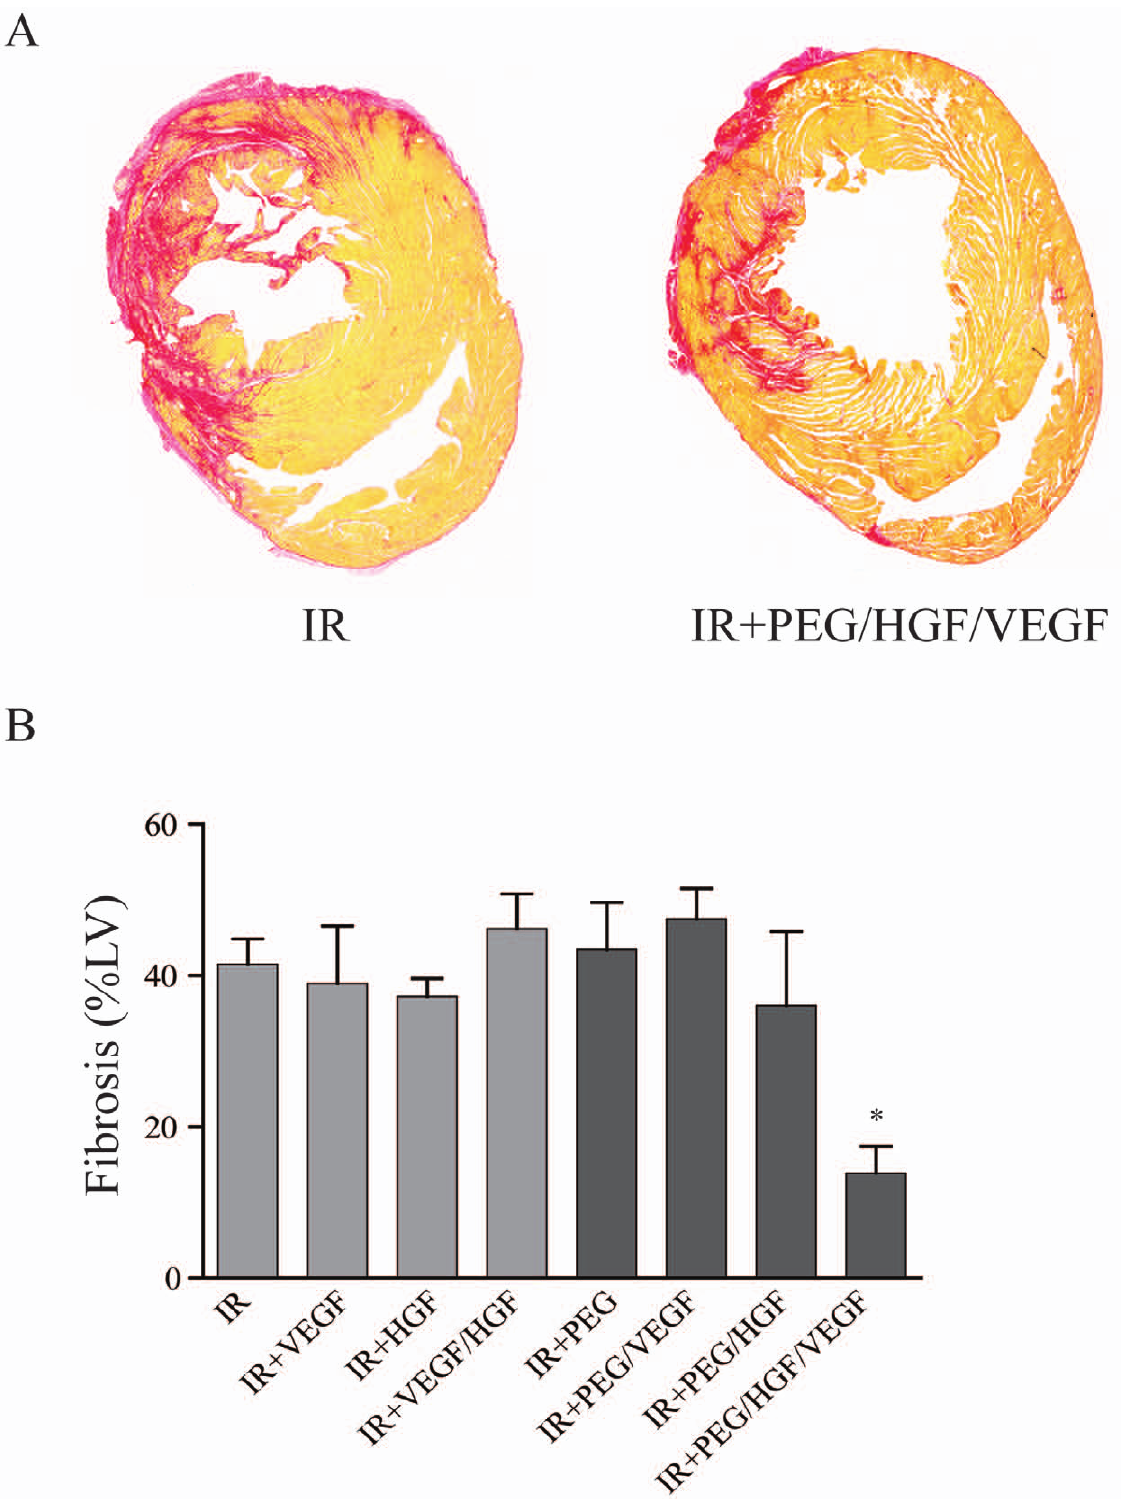
Figure 3. Fibrosis following ischemia-reperfusion in treated rats. At 21 days following infarction, fibrosis was measured by staining for collagen using picrosirius red (red stain, images taken at 20 6 magnification). A) Shows 2 representative stitched heart sections used for quantification (IR alone and IR + PEG/VEGF/HGF. B) Grouped data (mean 6 SEM; n $ 7 per group) demonstrating a significant decrease in fibrotic area in PEG/HGF/ VEGF rats compared with IR alone (*p , 0.05; ANOVA followed by Student-Newman-Keuls post-test). PEG=polyethyleneglycol, VEGF=vascular endothelial growth factor, HGF=hepatocyte growth factor, IR=ischemia reperfusion, LV=left ventricle.